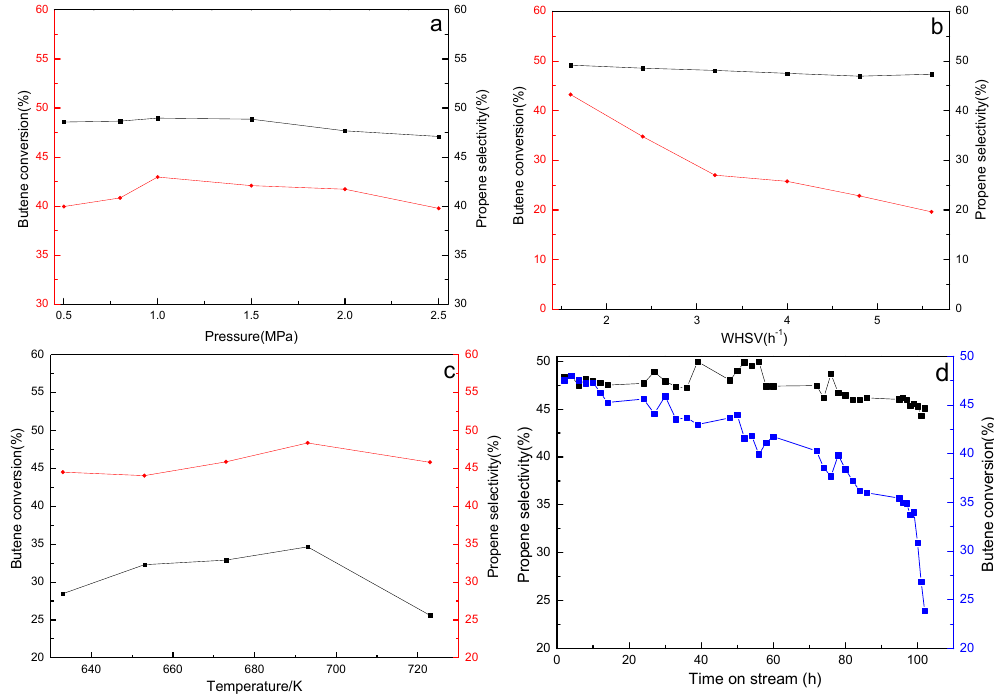
Figure 4. Propene selectivity and butene conversion under different conditions. ( a ) T = 573 K, WHSV = 3.2h -1 , ( b ) T = 573 K, P = 0.8MPa, ( c ) WHSV = 3.2h -1 , P = 0.8MPa, ( d ) T = 573 K, WHSV = 3.2h -1 , P = 0.8MPa.